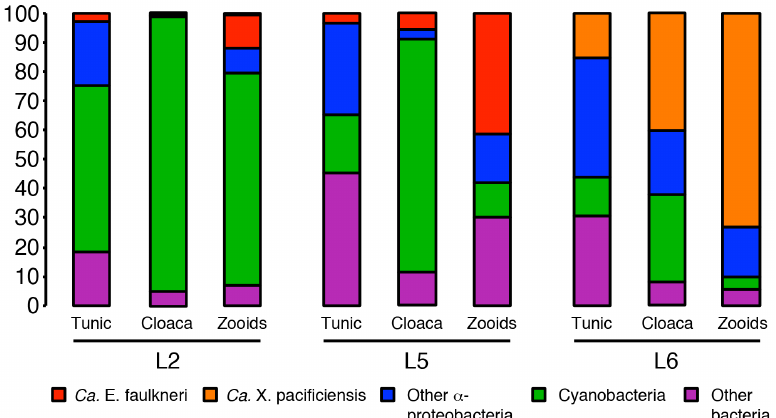
Figure 15. Microbiome variation in different tissues of L.patella animals L2, L5 and L6, determined by 454 16S rRNA gene amplicon sequencing. The content of Ca. E. faulkneri (red) and Ca. X. pacificiensis (orange) 16S rRNA is shown (in each case defined as sequences $ 98% identity to the 16S sequence in the relevant assembled genome).